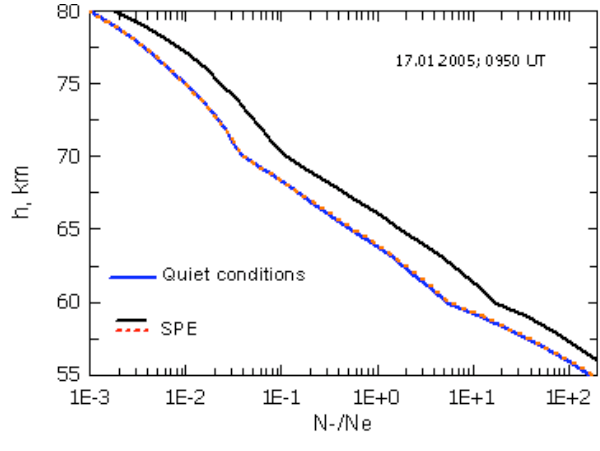
Fig. 7b. λ profiles calculated for quiet conditions (blue curve) using the O, O 3 and NO profiles 1–3 in Fig. 1 and for the SPE on 17 January 2005 at 09:50UT using profiles 4–6 in Fig. 1 (black curve) and 1–3 in Fig. 1 (red dashed curve).